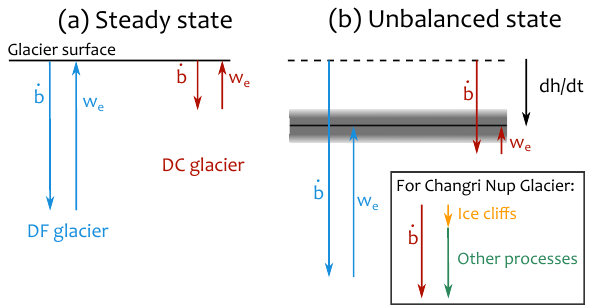
Figure 11. Conceptual representation of the interplay of net abla- tion ( ˙ b ) and emergence velocity ( w e ) for debris-free (DF, blue) and debris-covered (DC, brown) glacier tongues. In the left panel both glaciers are at equilibrium (no thinning) and in the right panel their tongues are thinning at roughly the same rate ∂h/∂t , shown by the grey-shaded area. In the unbalanced state, the values are scaled ac- cording to Vincent et al. (2016). For the steady state, we assumed a similar emergence velocity for the debris-free tongue. The inset shows the share of the ice cliffs versus the other processes for the tongue-wide ablation on Changri Nup Glacier tongue. It is notewor- thy that this representation is only conceptual, that it is based on our current understanding of the interplay of ablation and ice dynamics of a single small glacier tongue (Changri Nup), and that the emer- gence velocity values are very poorly